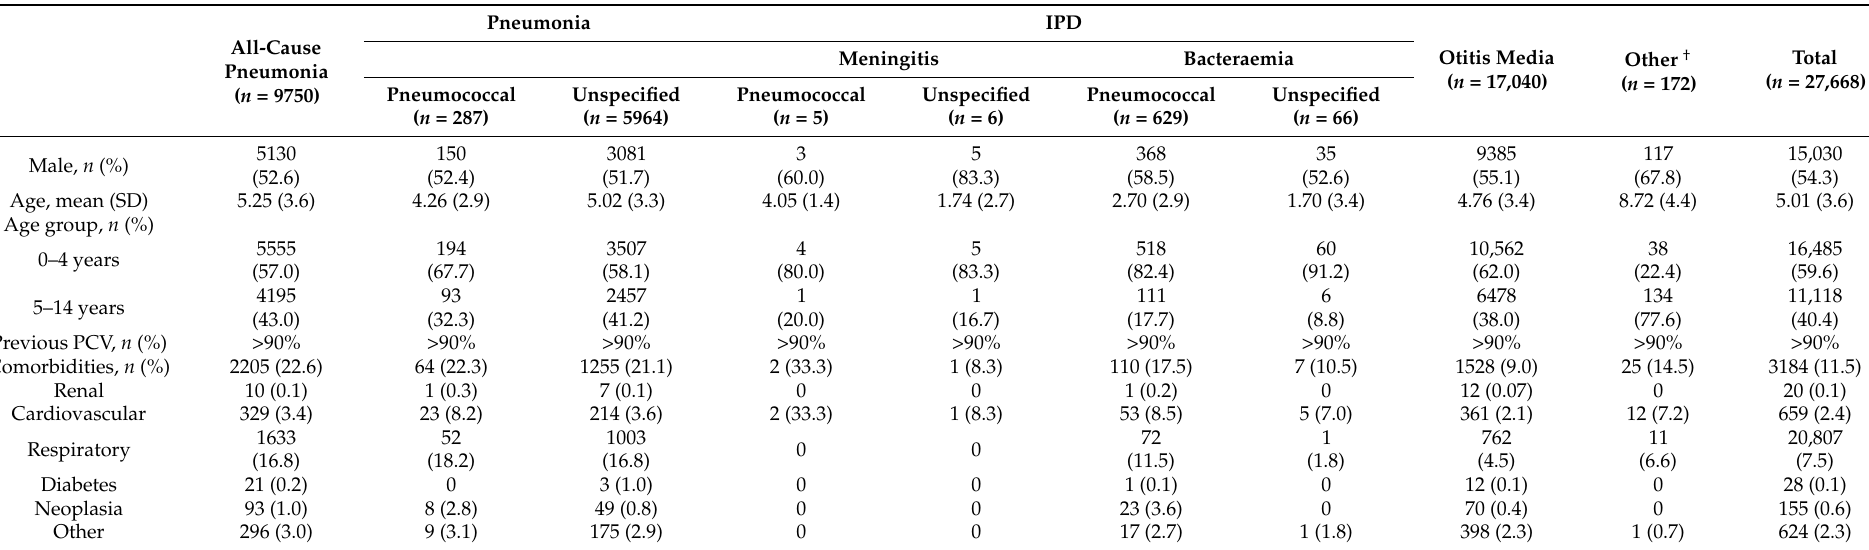
Table 1. Demographic characteristics and risk factors for invasive and non-invasive pneumonia episodes in children < 15 years of age